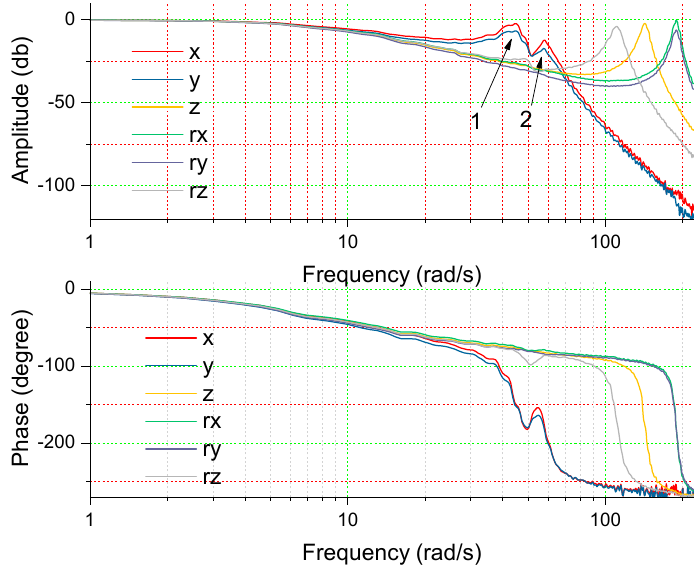
Figure 6. Bode diagram of the rigid-flexible simulation model.